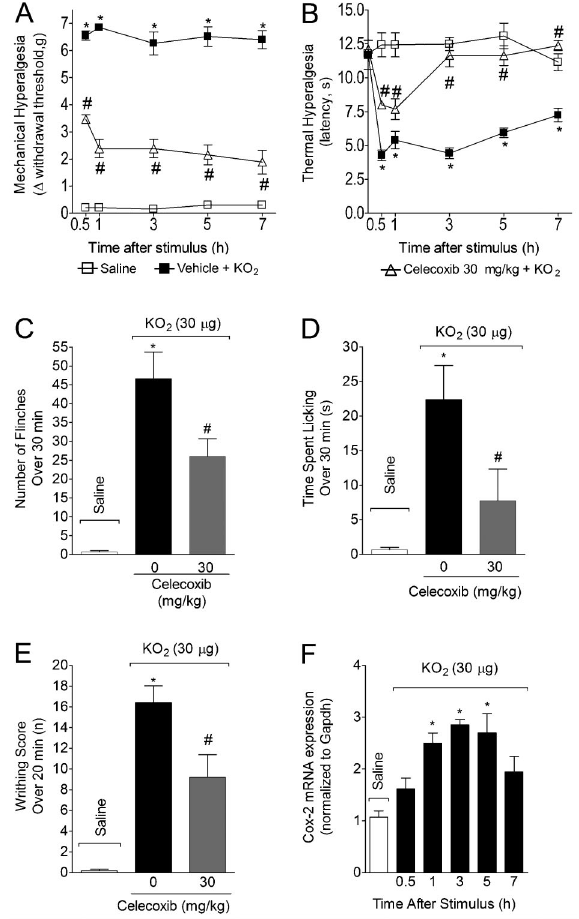
Figure 10. KO 2 induced COX-2-dependent nociception. Mice were treated with celecoxib (30 mg/kg, ip ) or vehicle (saline) 1 h before ipl (30 m g, 25 m L) or ip (1 mg/mice) injection of KO 2 . The intensity of mechanical hyperalgesia ( A ) and thermal hyperalge- sia ( B ) were measured 0.5-7 h after stimulus, paw flinching ( C ) and licking ( D ) were evaluated during 30 min, and writhing response was evaluated during 20 min ( E ). COX-2 mRNA expression ( F ) was evaluated by qPCR 0.5-7 h after ipl injection of KO 2 . Data are reported as means±SE. *P , 0.05 vs saline control; # P , 0.05 vs vehicle control (0 mg/kg) (one-way ANOVA followed by Tukey’s t